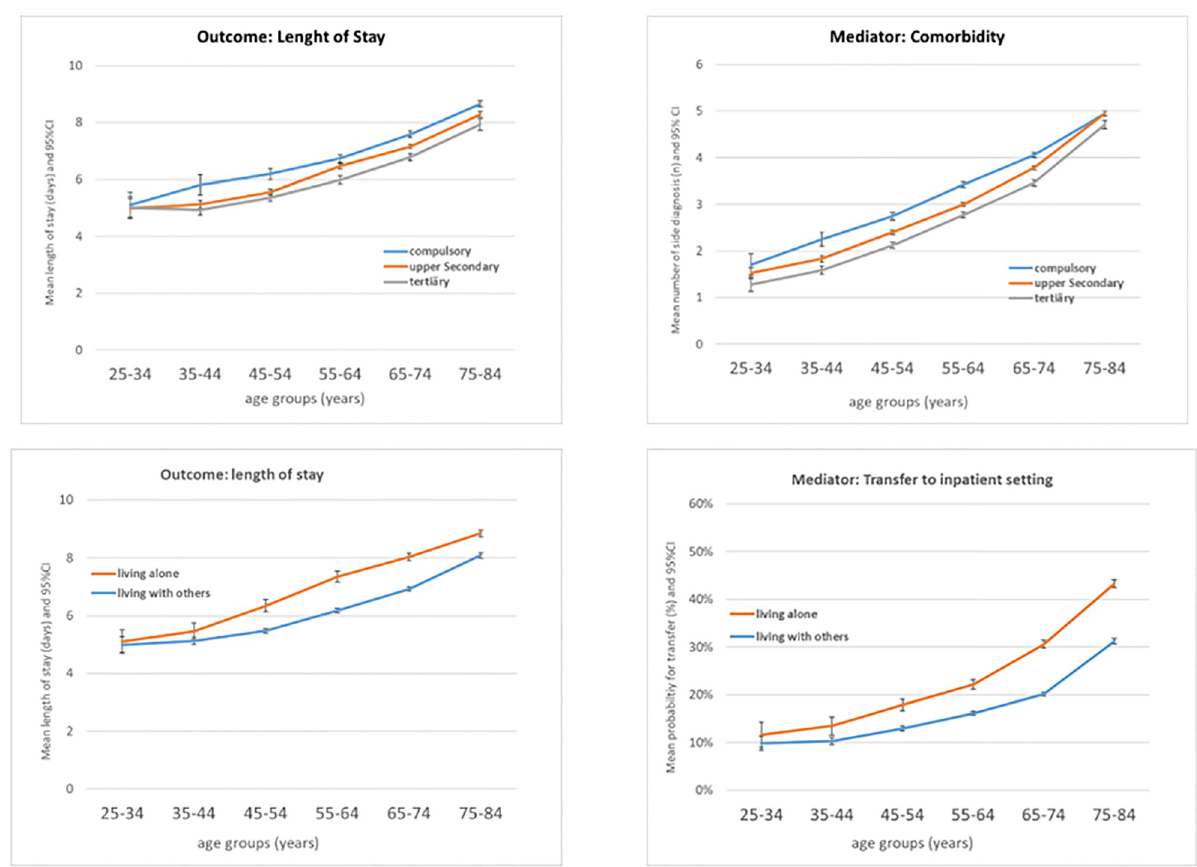
Fig 3. Top. Outcome length of stay (left) and mediator comorbidity (right) by age groups and educational attainment; bottom: Outcome length of stay (left) and mediator discharge destination (right) by age groups and household type.